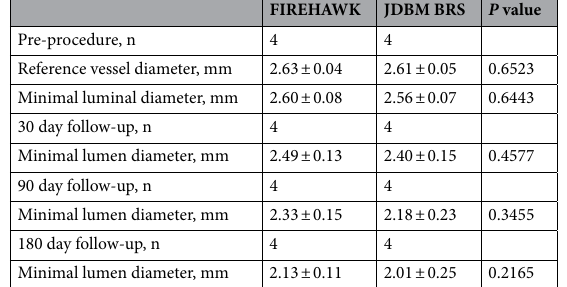
Table 1. Minimal lumen diameter of stented coronary artery segments measured by quantitative coronary angiographic (QCA). Values are expressed as mean ± SD. n: number of stented arterial